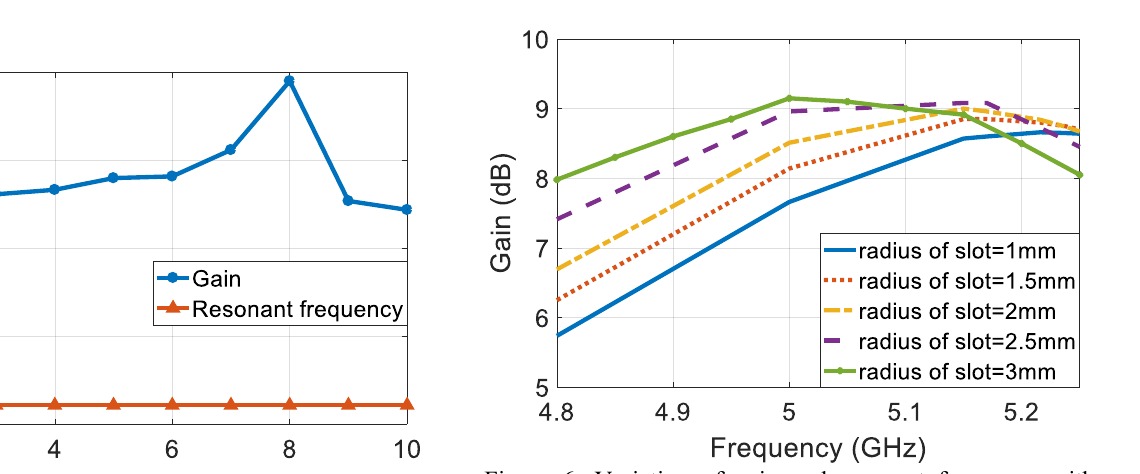
Figure 6: Variation of gain and resonant frequency with spacers length (spacers length =8 mm).